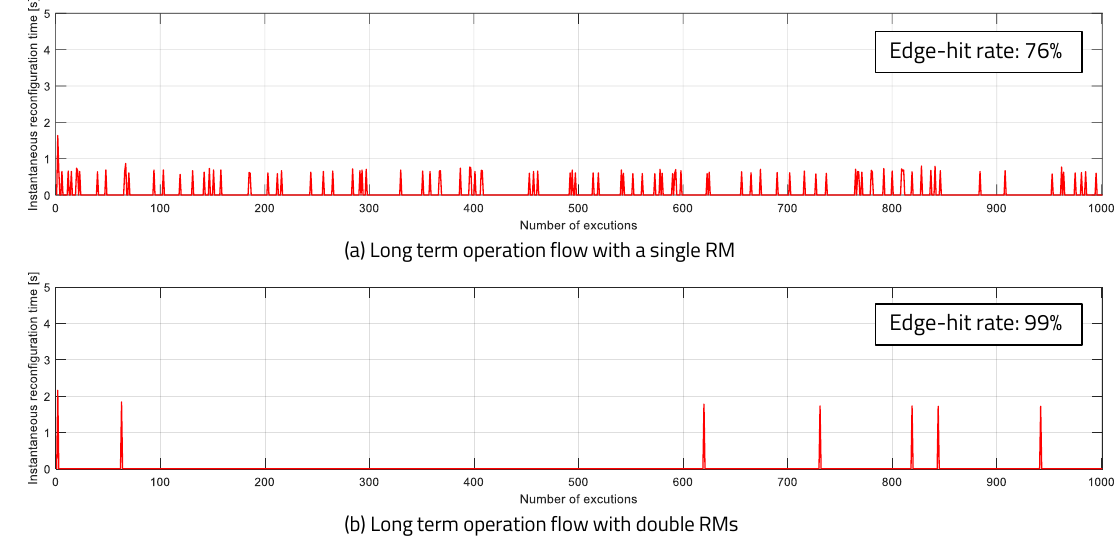
Figure 21. Long-term executions with Figure 14